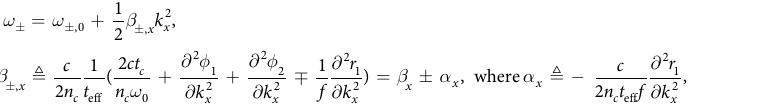
± , x are similar to that of a single cavity mode, β x in Eq. (1), except for the term, α x . This term accounts for the effect of coupling on dispersion. We need to note that this coupling term depends on the reflectivity amplitude, r 1 as in Fig. 2(b), the dispersion x curvatures of the two hybridized modes, β ± , x are identical to each other. As a result, the dispersion curves of the two hybridized modes are just two replicas of the single VCS curve (c.f. Fig. 2(a)) shifted in frequency. This case occurs when the reflectivity amplitude of the shared mirror, m 1 has negligible angular dependence, for example as in metallic mirrors and DBRs. On the other hand, if | α x | is comparable or larger than | β x |, as shown in Fig. 2(c,d), β + β − β , x and , x are different from each other as well as significantly differing from the single VCS value, x . Particularly, the case of Fig. 2(d) seems interesting, since there is a possibility of obtaining a Dirac-cone like point in dispersion characteristics close to the Γ -point, which will be discussed elsewhere. Thus, the dispersion property of the coupled VCS can be engineered to a larger extent than a single VCS case due to the coupling term in the dispersion curvature. Furthermore, as it is shown below, the additional reflector can provide new possibilities for the coupled VCS, which are not achievable for the single VCS, such as designing a mode with a large dispersion curvature while keeping Q-factor large, and dynamical tuning of dispersion curvature.